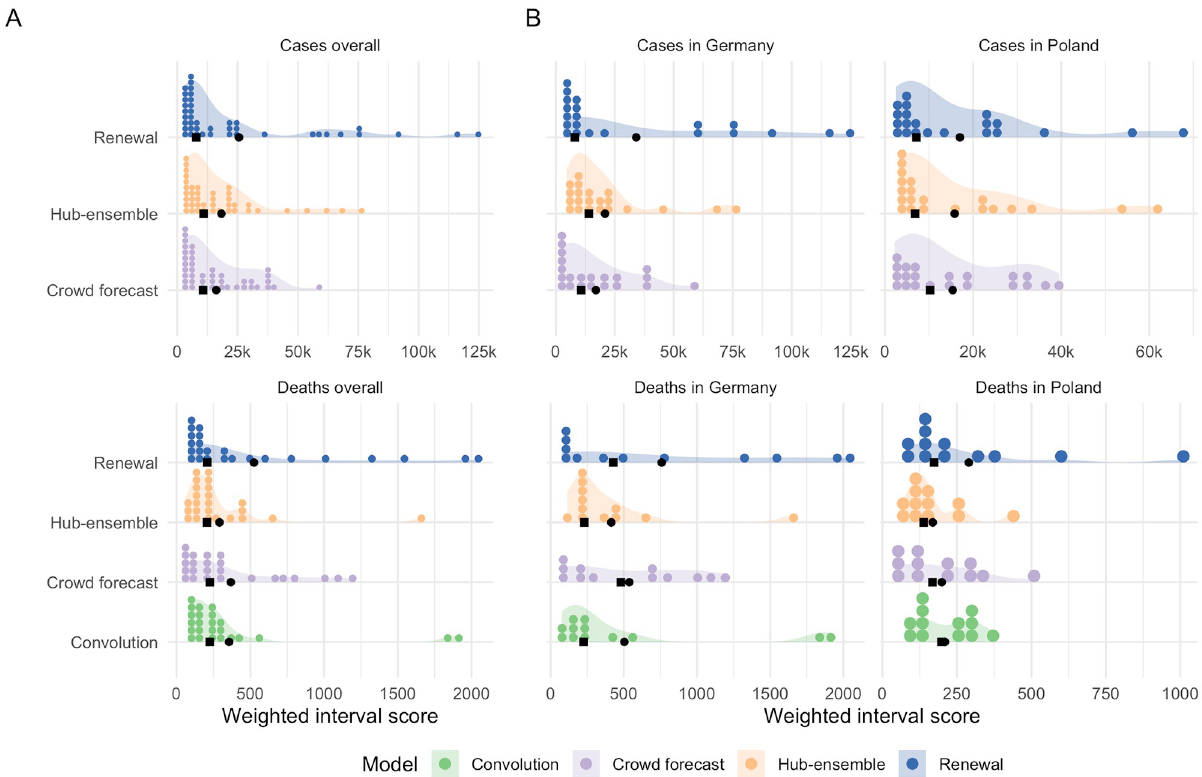
Fig 2. Two week ahead forecasts and corresponding scores. A, C: Visualisation of 50% prediction intervals of two week ahead forecasts against the reported values. Forecasts that were not scored (because there was no complete set of death forecasts available) are greyed out. B, D: Visualisation of corresponding